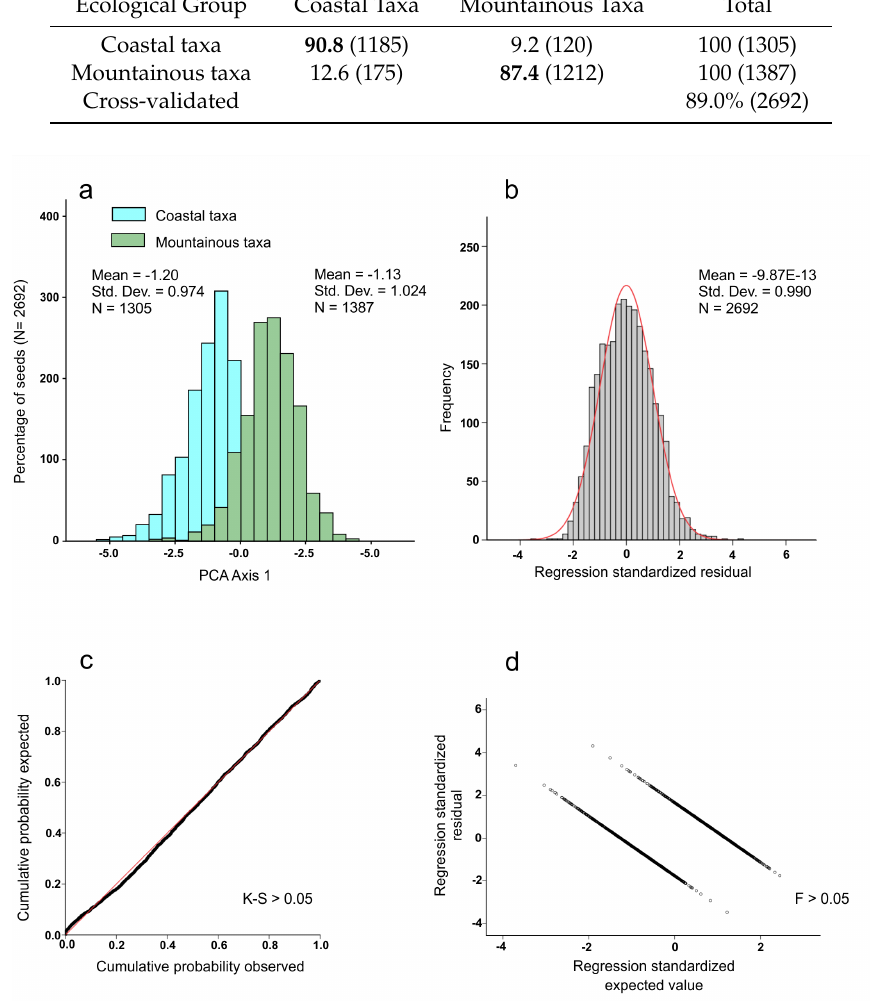
Figure 1. ( a ) Graphical representation of the discriminating function scores for coastal and mountainous Anchusa taxa; ( b ) Histogram of the standardized residuals; ( c ) Dispersion plot of the standardized residuals tested with Levene’s test (F); ( d ) Normal probability plot (P-P) tested with Kolmogorov–Smirnov’s test